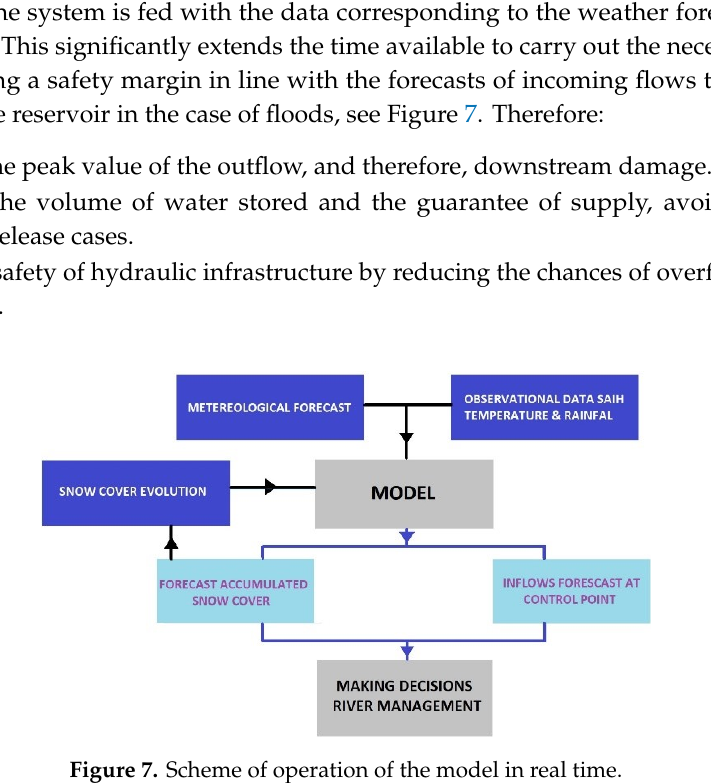
Figure 7. Scheme of operation of the model in real time.